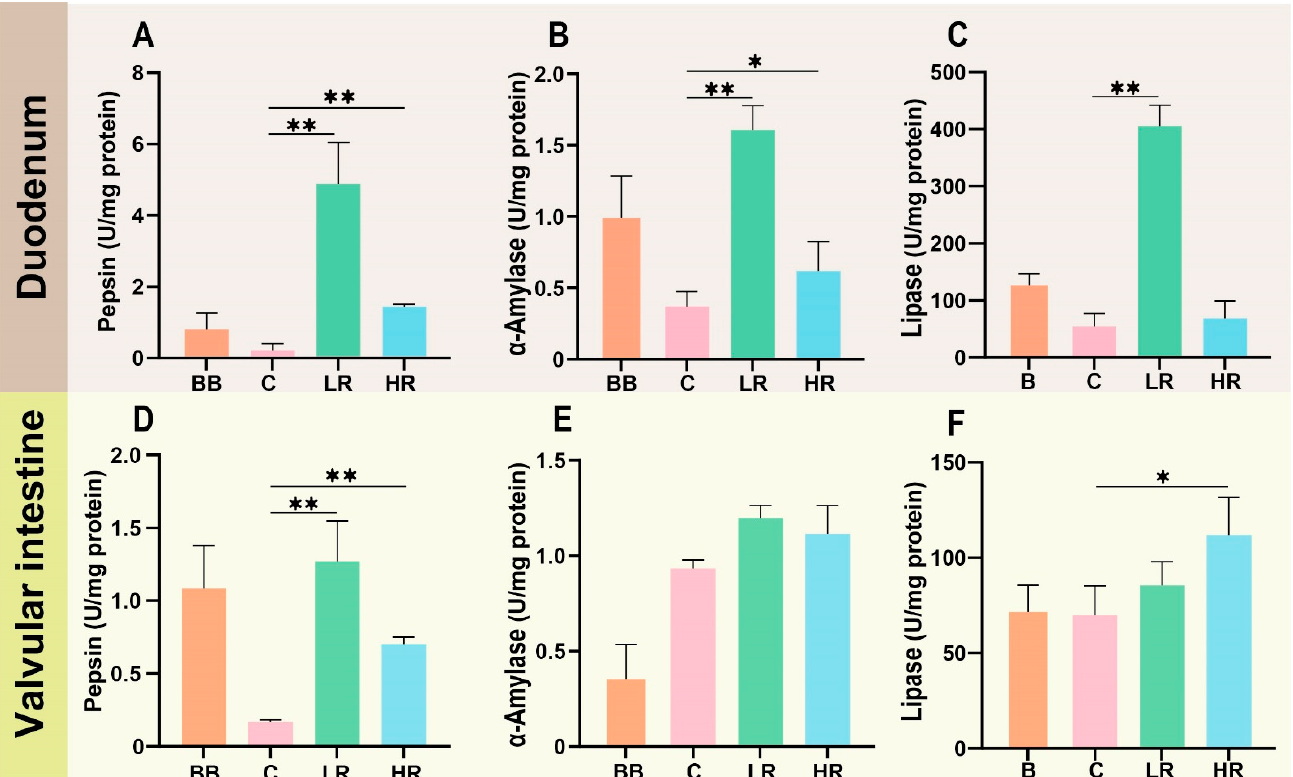
Figure 2. Effects of resveratrol on the activity of intestinal digestive enzymes. ( A – C ) Pepsin, α -amylase, lipase activity in the duodenum. ( D – F ) Pepsin, α -amylase, lipase activity in the valvular intestine. * p < 0.05, ** p < 0.01 vs. the control group; one-way ANOVA plus Bonferroni